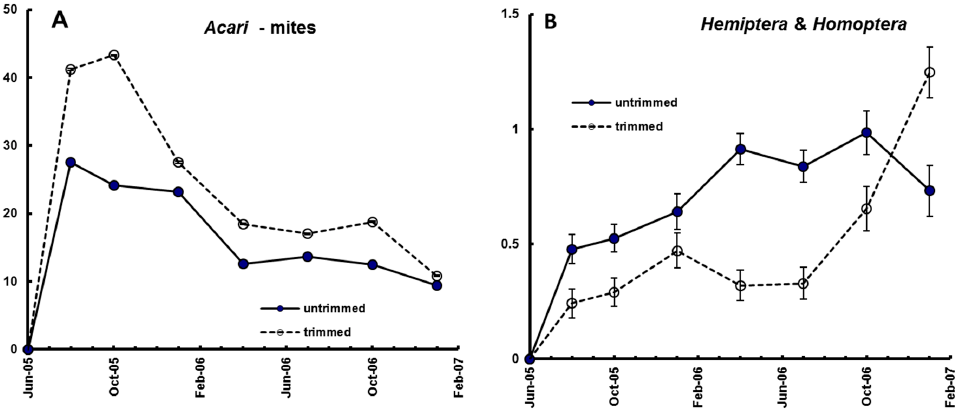
Figure 5. Examples of the effect of canopy trimming on mean number of animals per litterbag. ( A ) Acari ; ( B ) Hemiptera & Homoptera . For other taxonomic groups see [19].